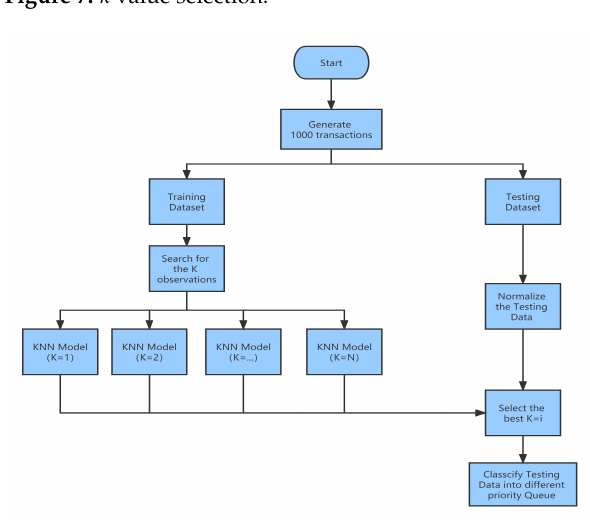
Figure 7. k value selection.